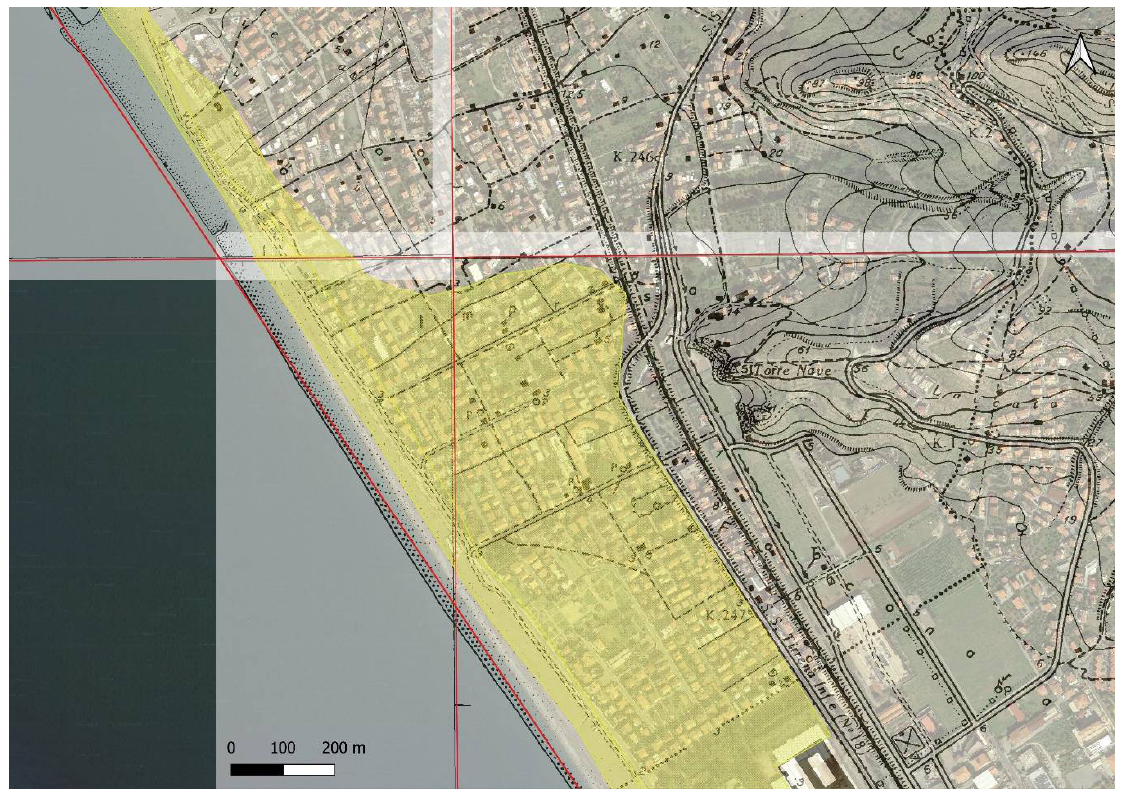
Figure 6. Guardia Piemontese: overlap between CASMEZ cartography and the most recent Google satellite image. Legend: red line = shoreline of 1954; yellow dotted area = dune systems of 1950s.